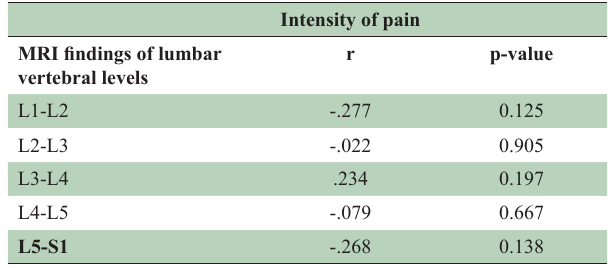
Table-I: General demographic features and frequency of pain severity, duration and site.